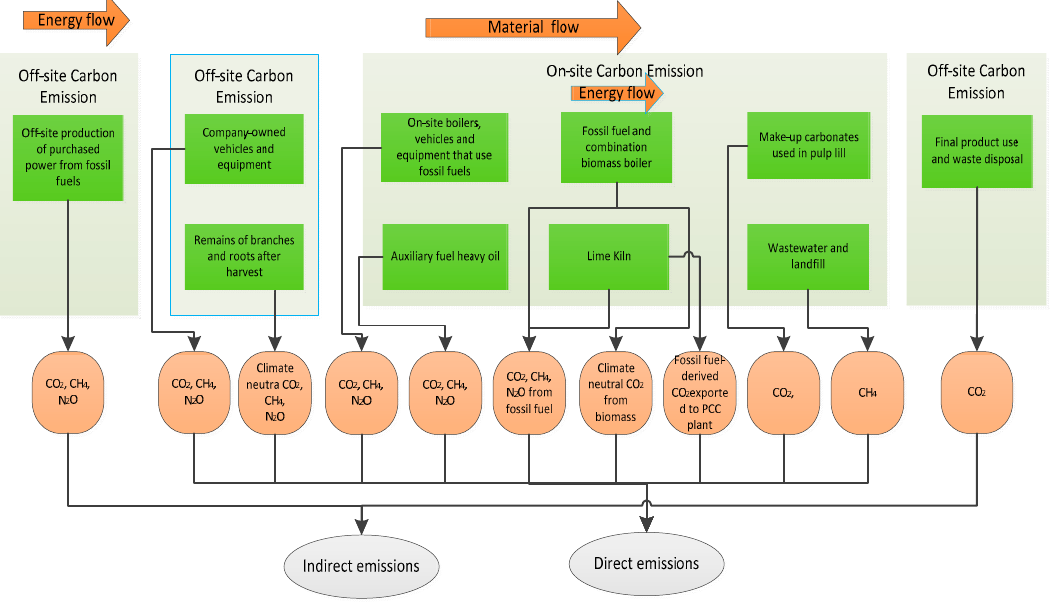
Figure 2. Framework of the carbon footprint.